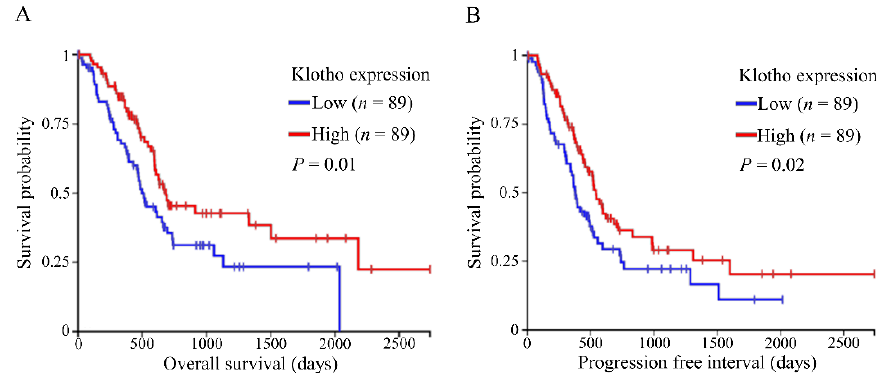
Figure 1. Low klotho expression reduces survival of pancreatic cancer patients. ( A , B ) The UCSC Xena Browser was used to examine The Cancer Genome Atlas (TCGA) Pancreatic Cancer (PAAD) cohort. Gene expression RNAseq (IlluminaHiSeq) dataset was analyzed for overall survival, and progression-free interval of patients with low (<5.675, n = 89) vs. high ( ≥ 5.675, n = 89) klotho expressing tumors.